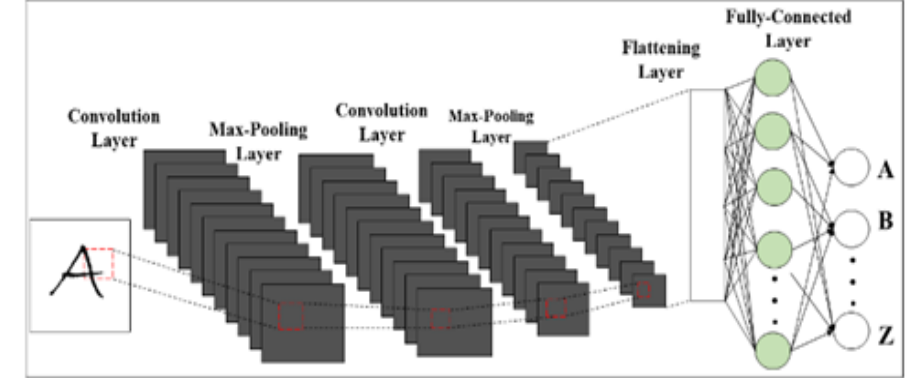
Fig. 1. Typical CNN